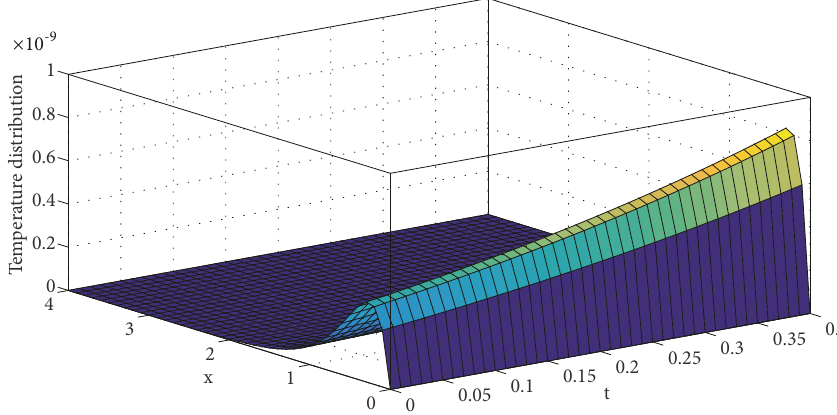
Figure 17: Profile of temperature distribution at 𝑛 = 1.0 , 𝐻 0 = 10 5 , and Ω = 0.5